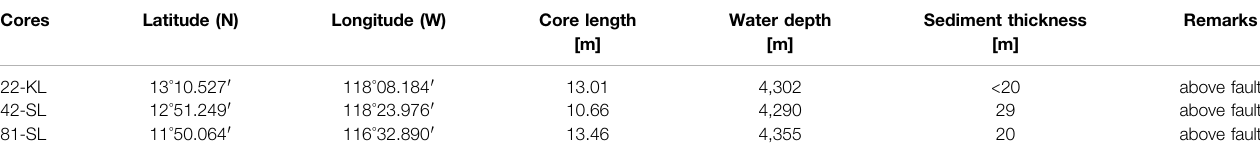
TABLE 1 | Coordinates, recovered piston (KL) and gravity (SL) core lengths, water depths and sediment thickness of selected SO-240 coring sites.